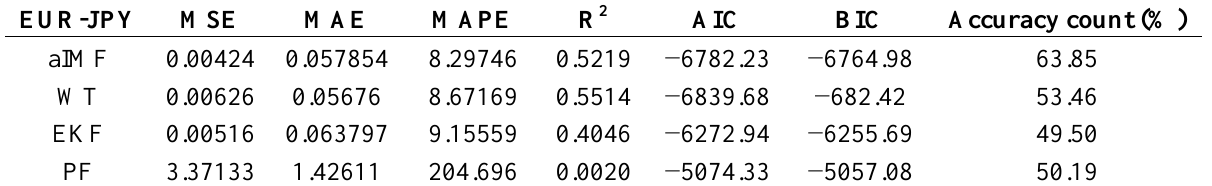
Table 7. Performance measurements of original dataset, EUR-JPY, using noise distribution at 10% with 10 Hz and 20% amplitude of the original signals’.